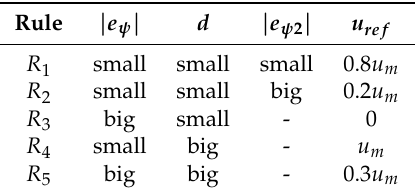
Figure 21. Membership functions of the fuzzy set of the outer loop. Table 1. The control rules for the velocity